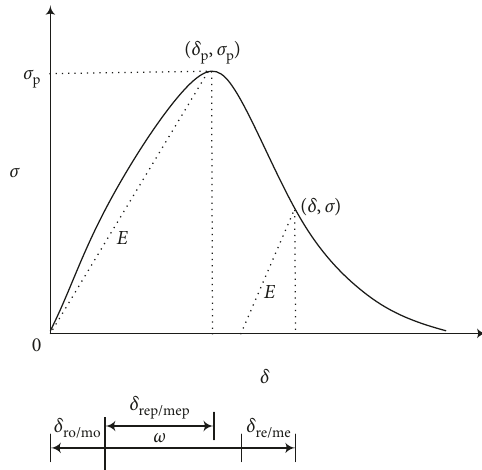
Figure 5: Schematic of axial-stress-deformation